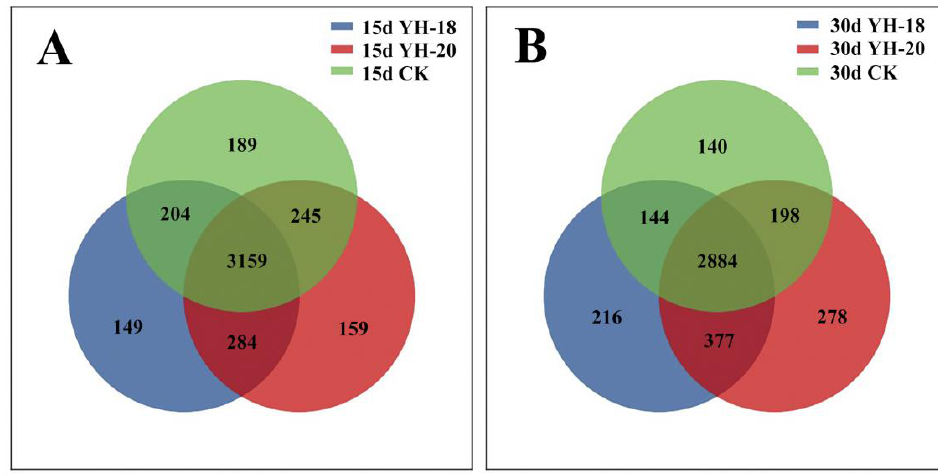
Figure 5. Venn diagram of different combinations: ( A ) Venn diagram of different treatments 15 days after inoculation. ( B ) Venn diagram of different treatments 30 days after inoculation.